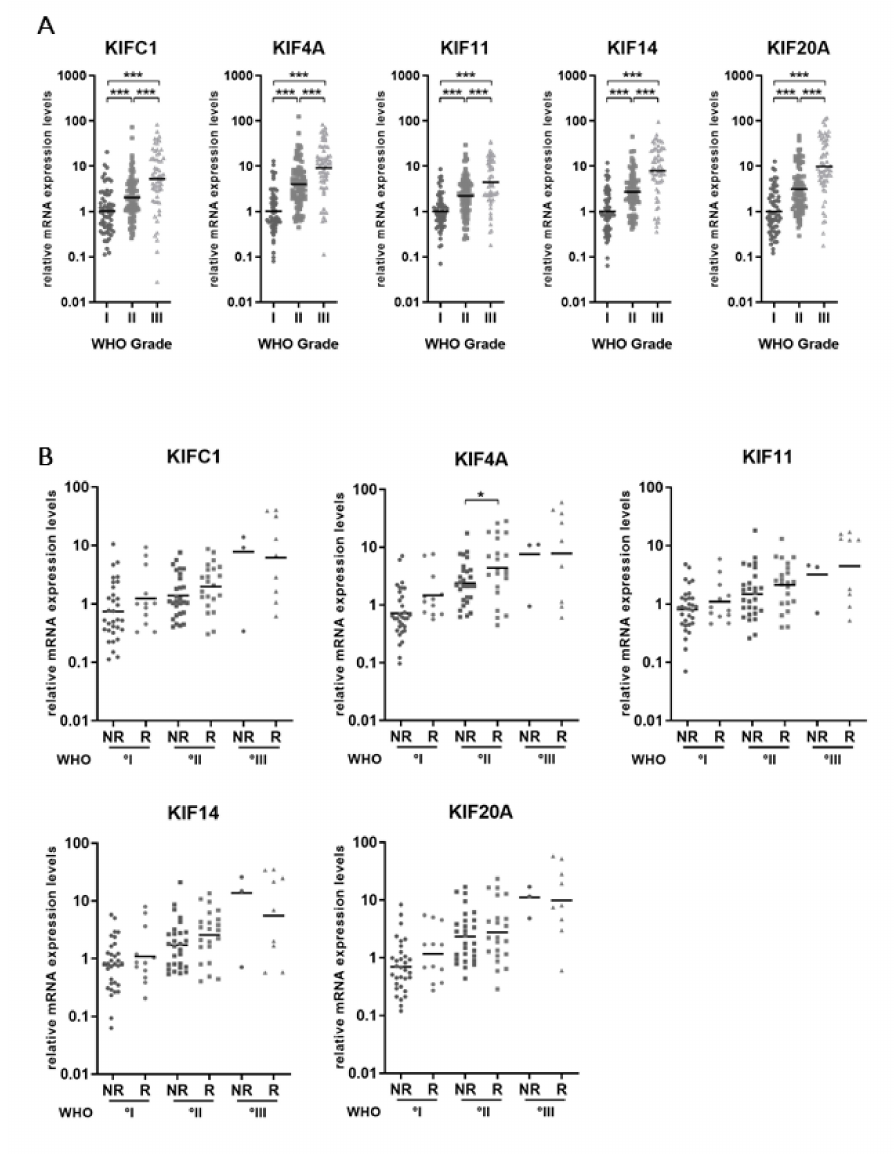
Figure1. mRNAexpressionlevels ofkinesin familymembers increase withWHO gradein meningiomas. ( A ) qRT-PCR expression data for KIFC1, KIF4A, KIF11, KIF14A and KIF20A are shown. mRNA